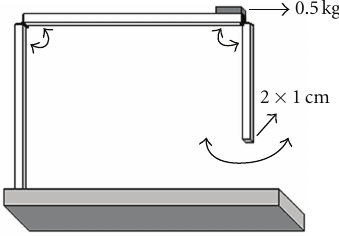
Figure 1: Standart peritoneal adhesion creation apparatus.